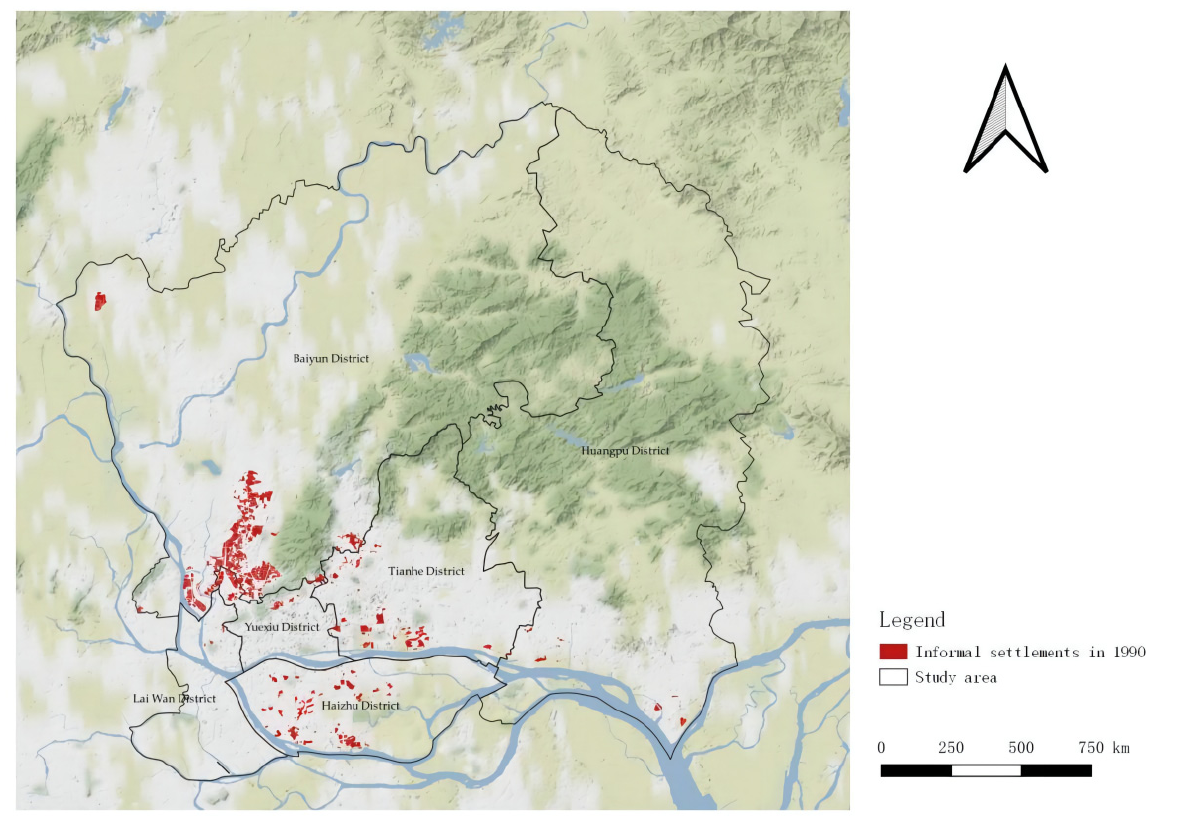
Figure 4. The spatial distribution characteristics of the informal settlements in 1990. Source: drawn by the authors. The background image is from the Stamen map.